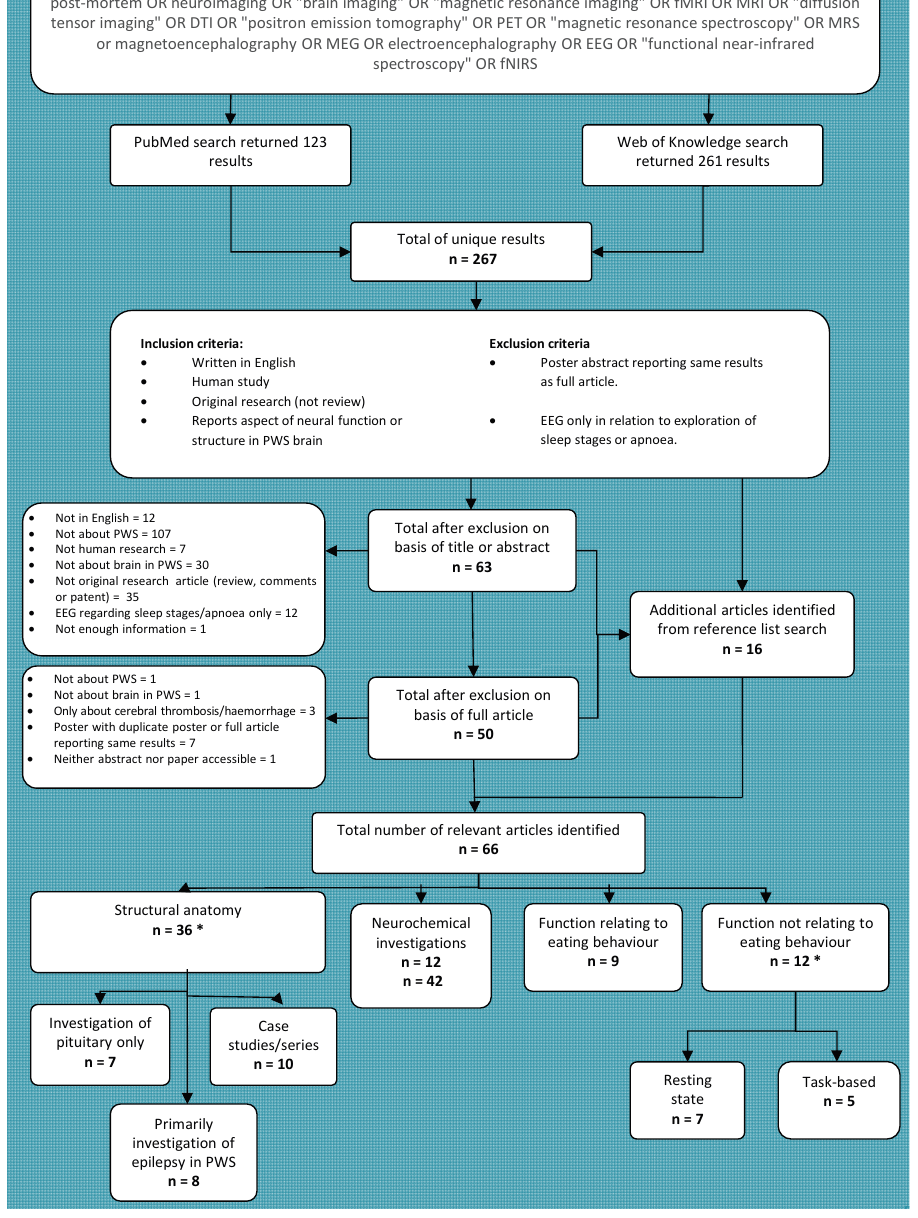
Figure 1. Article identification process for systematic literature review of neural structure and function in Prader-Willi syndrome (PWS). Literature search was carried out on 28 April 2015. Note that subcategories (e.g., case studies/series) within each main category (e.g., structural anatomy) are not mutually exclusive and references may be featured in more than one subcategory. * : One study features in both